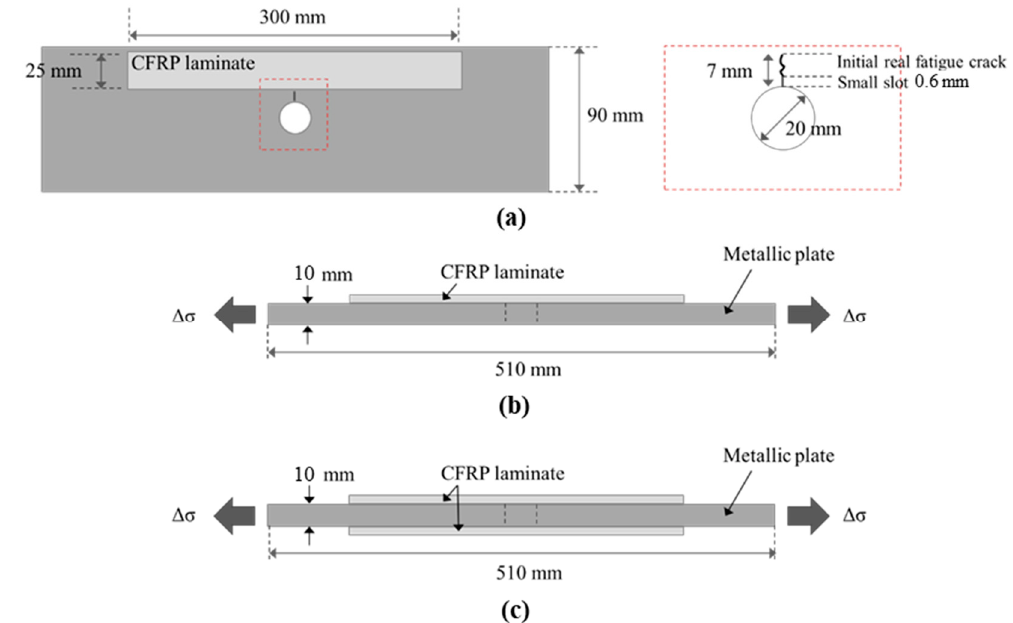
Figure 1. Configuration of CFRP (carbon fiber reinforced polymer) reinforcement for cracked metallic plates (not to Scheme 165. GPa (in fiber’s direction) and a thickness of 1.2 mm, and the UHM (ultra-high modulus) pultruded CFRP laminate had a Young modulus of 460 GPa (in fiber’s direction) and a thickness of 2.3 mm. The material properties of the CFRP laminates, the associated adhesives and the steel plates are listed in Table 1. ( a ) plan view, ( b ) section view of single-side repaired specimens, ( c ) section view of double-side repaired specimens. Table 1. Measured properties of metallic, carbon fiber reinforced polymer (CFRP) and adhesive materials. Material